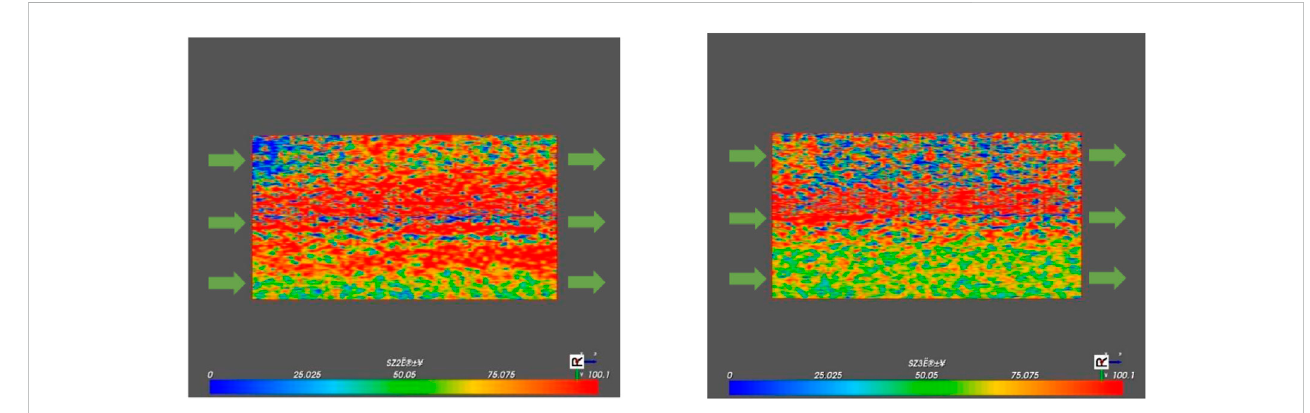
FIGURE 15 Final oil-water saturation distribution of SZ2 (left image) and SZ3 (right image) model